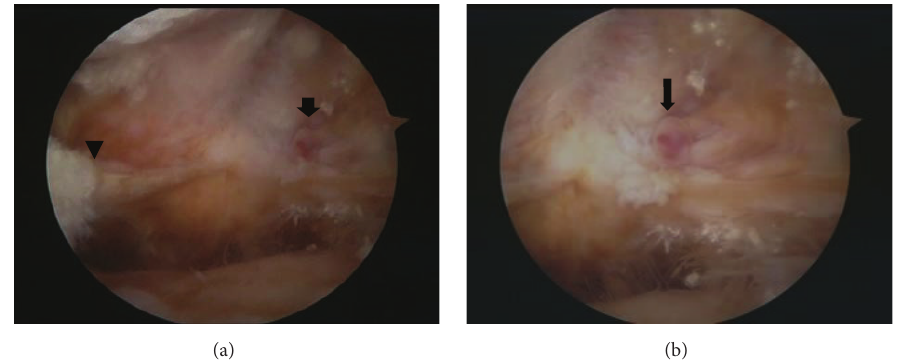
Figure 6: Arthroscopic findings of Case 2 . Remarkable degenerative change is shown in the lateral compartment. The middle and posterior portions of the lateral meniscus are degeneratively torn (arrow head) and almost no meniscal substance was left in these portions (a). On the exposed synovium behind this area, a small projecting tubular soft tissue with pulsation (arrows) is shown (a and